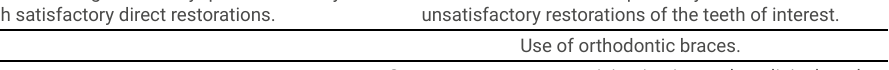
Table 1. Criteria used for patients’ recruitment accepted by the Araraquara Dental School Research and Ethics Committee (#75/11-FOAr/UNESP). Criteria of Inclusion Criteria of Exclusion Age between 18-80 years Pregnancy Absence of caries and/or periodontal disease Allergic reaction known and informed of any material used. in the maxillary right quadrant. Teeth of the right maxillary quadrant healthy or with satisfactory direct